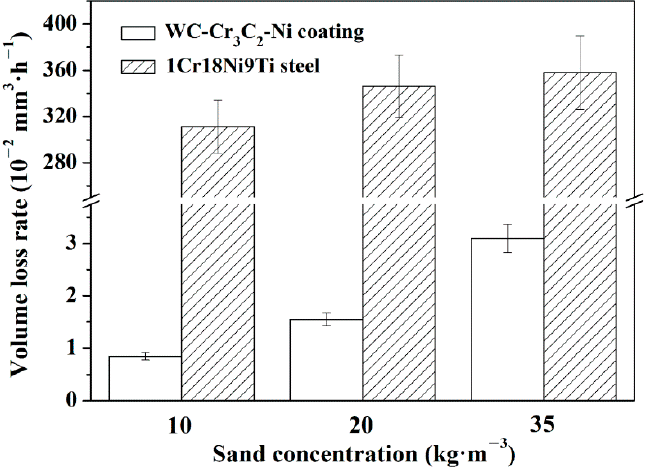
Figure 5. Volume loss rates of the WC-Cr 3 C 2 -Ni coating and the 1Cr18Ni9Ti stainless steel after HAE for 6 h in 3.5 wt.% NaCl aqueous solution at 33.5 m·s − 1 and different SCs. for 6 h in 3.5 wt.% NaCl aqueous solution at 33.5 m · s − 1 and different